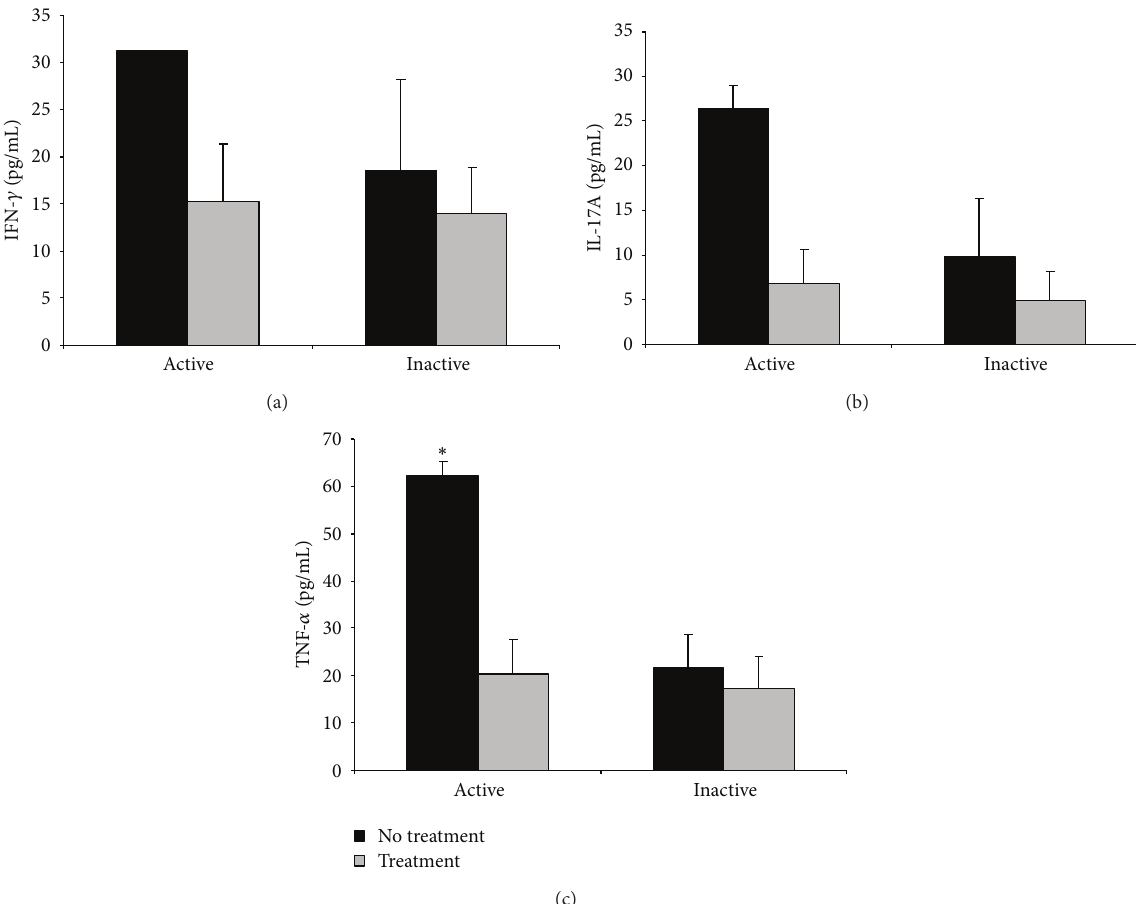
Figure4:EffectoftreatmentoncirculatinglevelsofIFN- 𝛾 ,IL-17A,andTNF- 𝛼 (pg/mL) ± SEMinpatientswithactiveandinactiveBD.Results are expressed as mean values of cytokine levels (pg/mL) ± SEM. Statistical analysis was performed by Mann Whitney U -test ( ∗ 𝑃 < 0.05